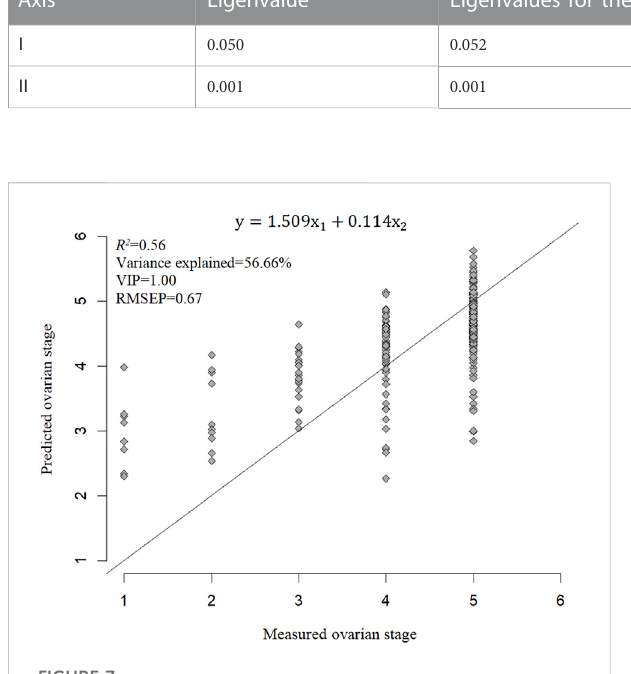
FIGURE 7 PLSpredictionofovariandevelopmental parameters forStage.In this model, y was stage, x 1 , x 2 were body weight, body length, respectively.